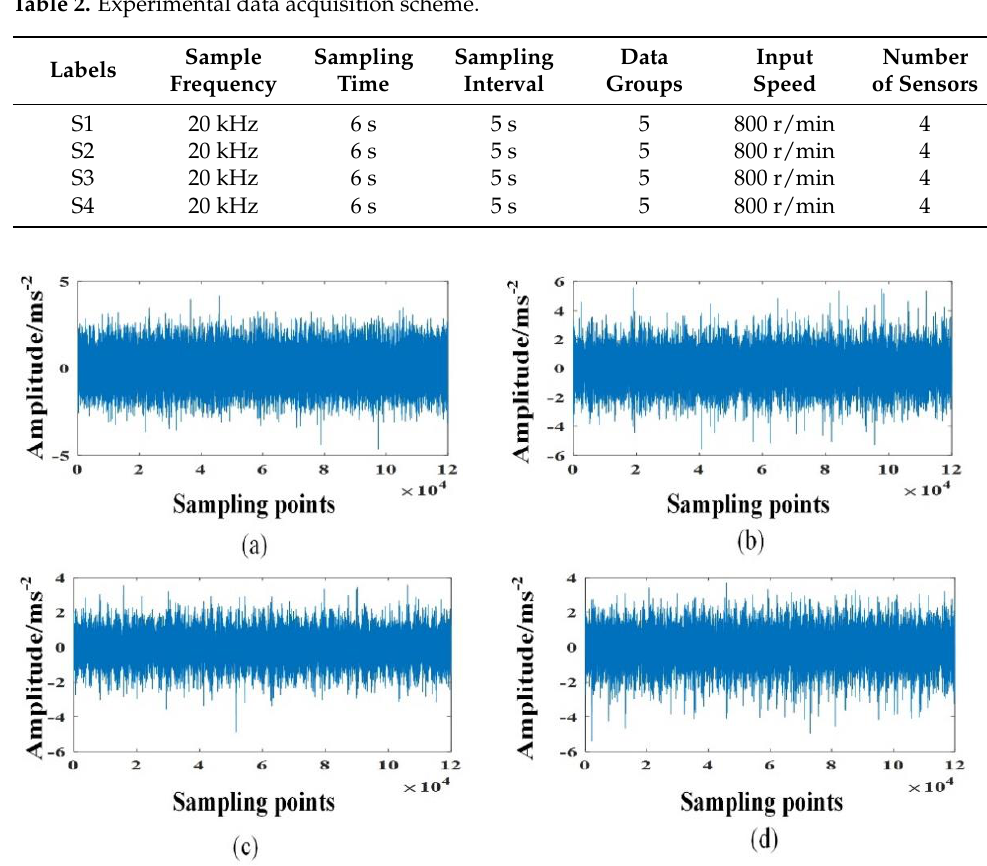
Figure 10. Vibration waveforms of gear reducer under four different states: ( a ) S1 state, ( b ) S2 state, ( c ) S3 status, ( d ) S4 state.